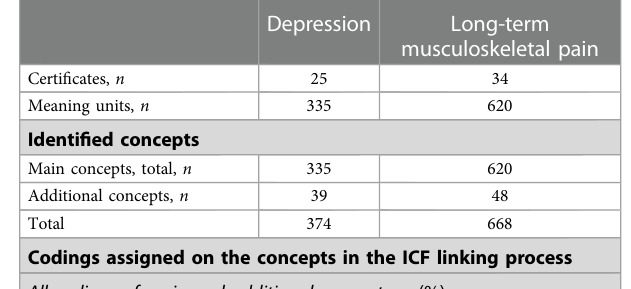
TABLE 2 Result of the ICF linking process of health data on work-related disability in sick leave certi fi cates issued for depression and long-term musculoskeletal